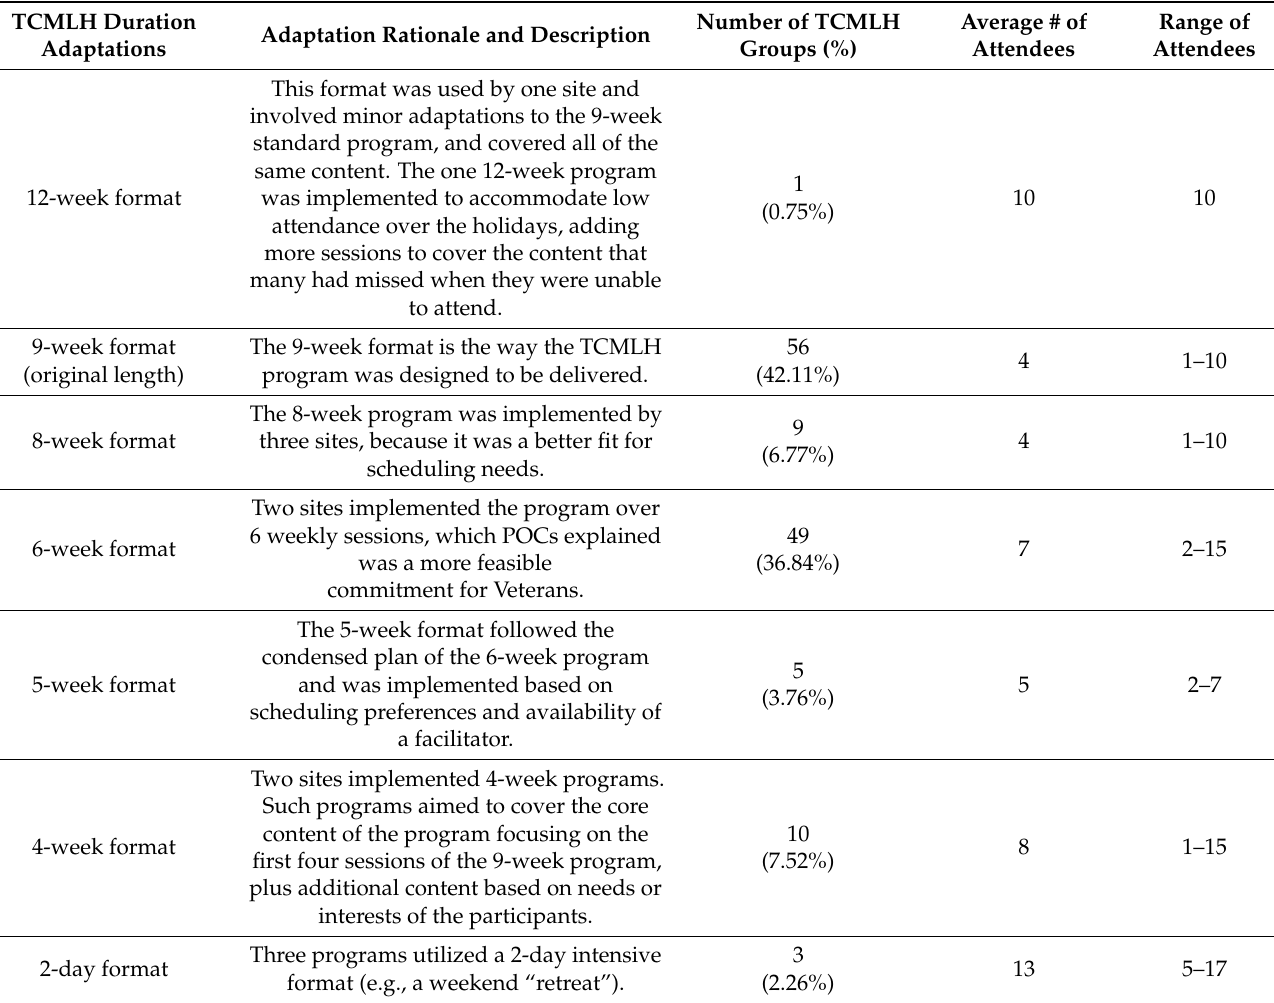
Table 5. TCMLH Adaptations and Attendance by Reporting Years,